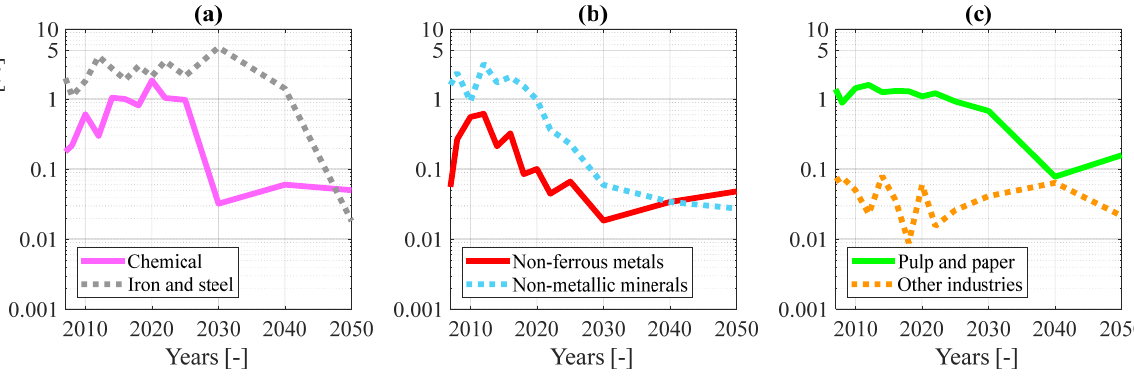
Figure 6. Average relative difference curves associated to the optimal technology mix for: ( a ) chemical and iron and steel sectors; ( b ) non-ferrous metals and non-metallic minerals sectors; ( c ) pulp and paper and other industries.